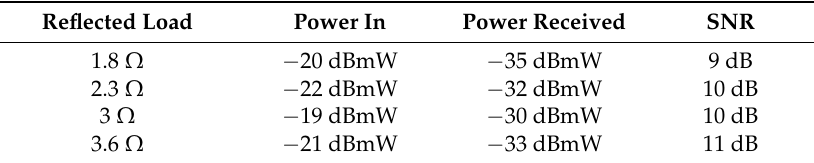
Table 3. Results obtained at the communication frequency.